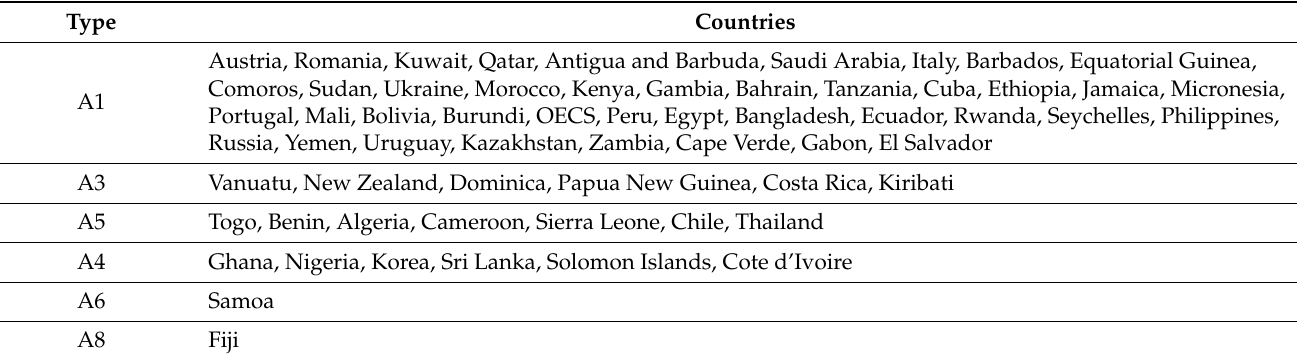
Table 5. Results of the analysis of the multilayer network of relations for category IV agricultural trade.